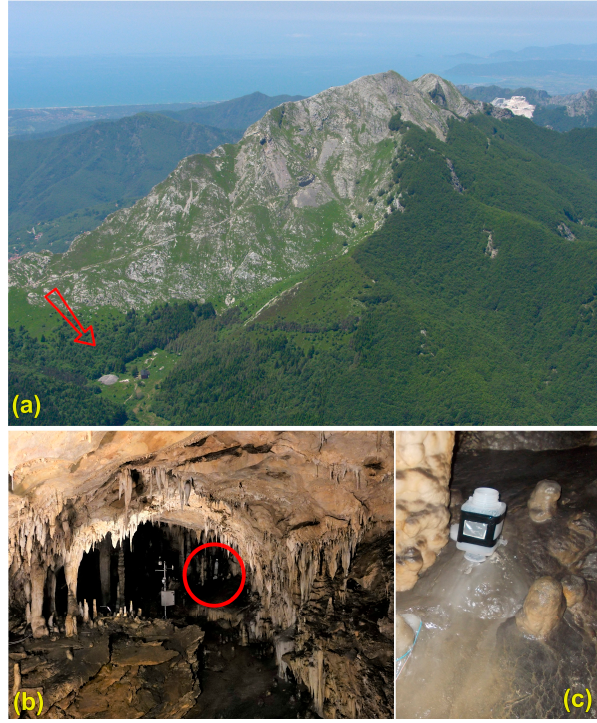
Figure 2. ( a ) Panoramic view of Monte Corchia from the South; the red arrow indicates the probable infiltration area feeding the Stalactites Gallery drips; ( b ) the Stalactites Gallery where the ARPAT monitoring station is placed. The red circle shows the main sampling site of Moraria sp.; ( c ) plas- tic container (mouth diameter 5 cm, volume 500 mL) used to collect the dripping water in the Corchia